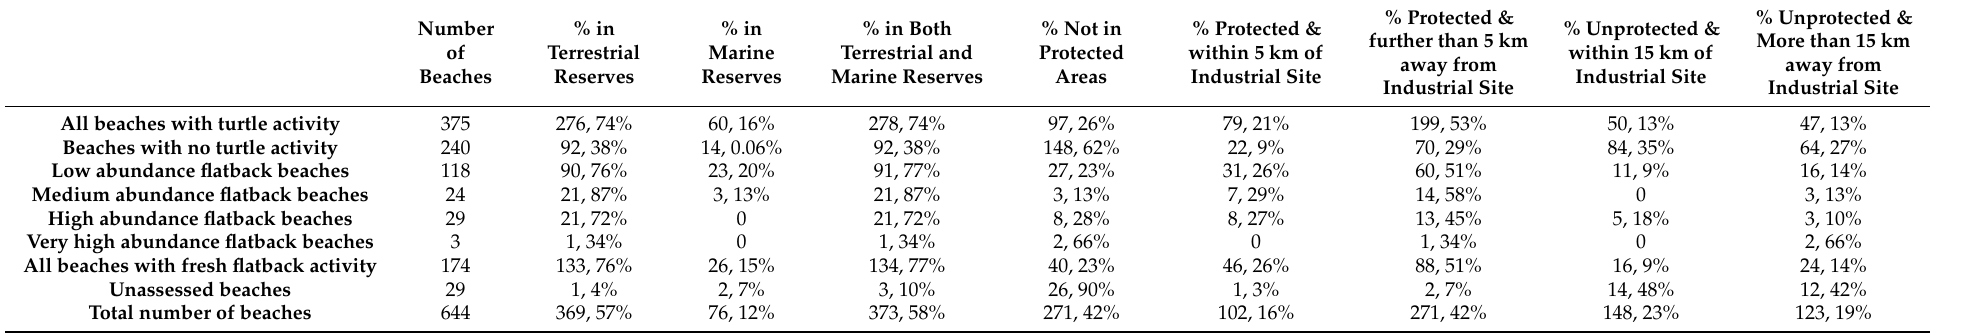
Table 1. Overlap of turtle nesting beaches in the Pilbara region of Western Australia with marine and terrestrial reserves and distance to industrial sites. Turtle activity was defined as any track, nest or body pit of any age observed on a beach and/or in the sand dunes and made by any species of marine turtle. Flatback beaches were defined as beaches where evidence of fresh nesting activity from flatback turtles was found. Fresh flatback abundance was defined as number of fresh (i.e., made within the previous 0 to 36 h.) down-tracks per night per beach. Unassessed beaches were beaches for which the quality of the aerial imagery was too poor to identify any turtle activity. Beach abundance (flatback tracks · night − 1 ) ranked as follows: 1 to 4 (low), 5 to 9 (medium), 10 to 49 (high), and 50 to 249 (very